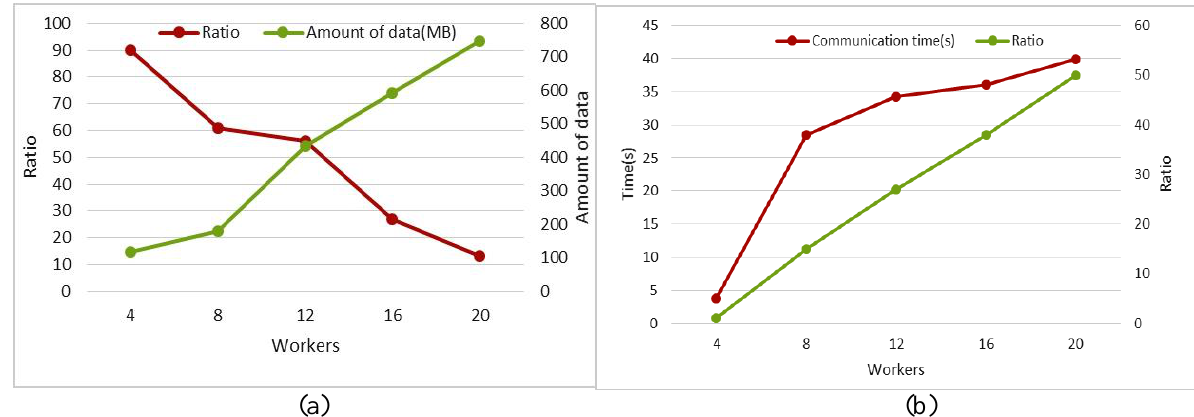
Figure 11. Transferred data in Mb and ratio of computation to total time in Job 2 (a). Communication time and ratio of communication to total time in Job 2